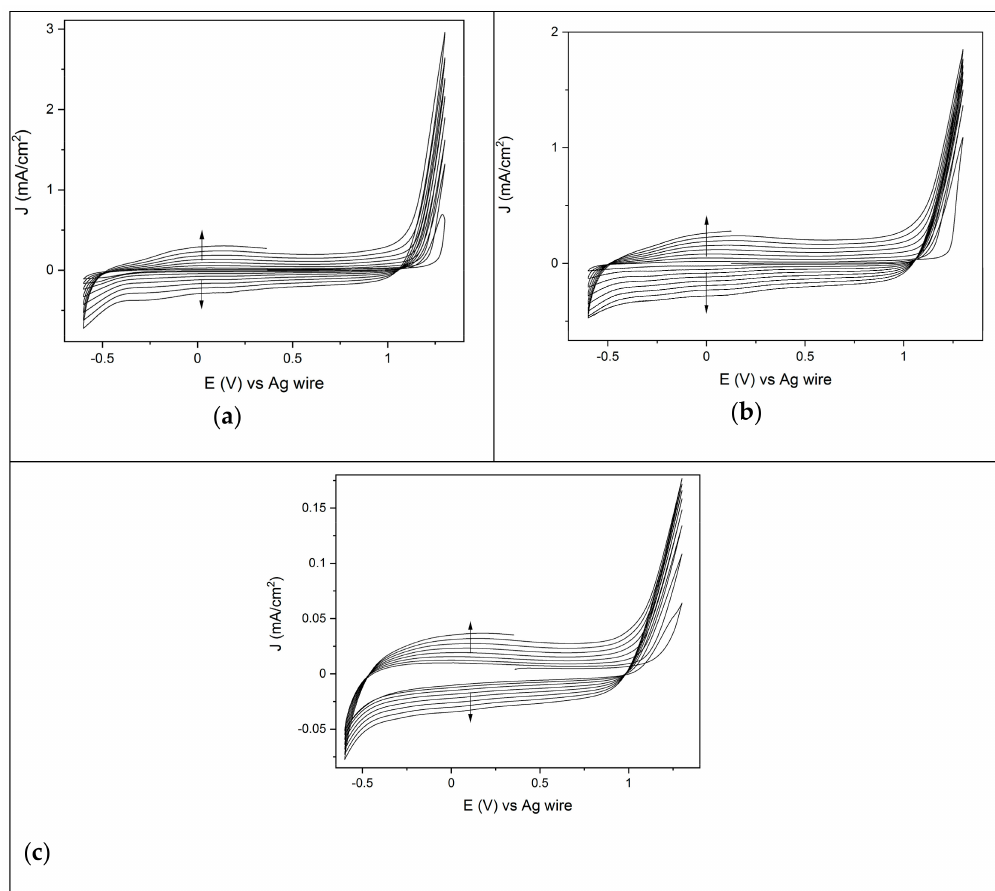
Figure 1. Eight consecutive CVs of the EDOT solution between − 0.6 V and 1.3 V, starting from the OCP, scan rate 50 mV/s, on the various substrates: ( a ) gold, ( b ) palladium and ( c )